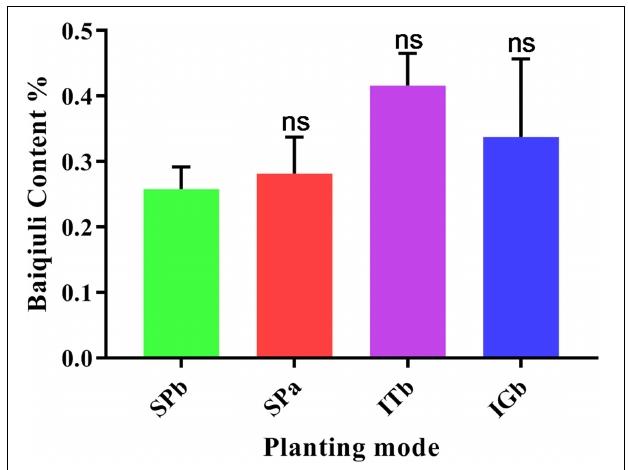
FIGURE 9 | Baiqiuli content in the patchouli when the various planting modes were applied.